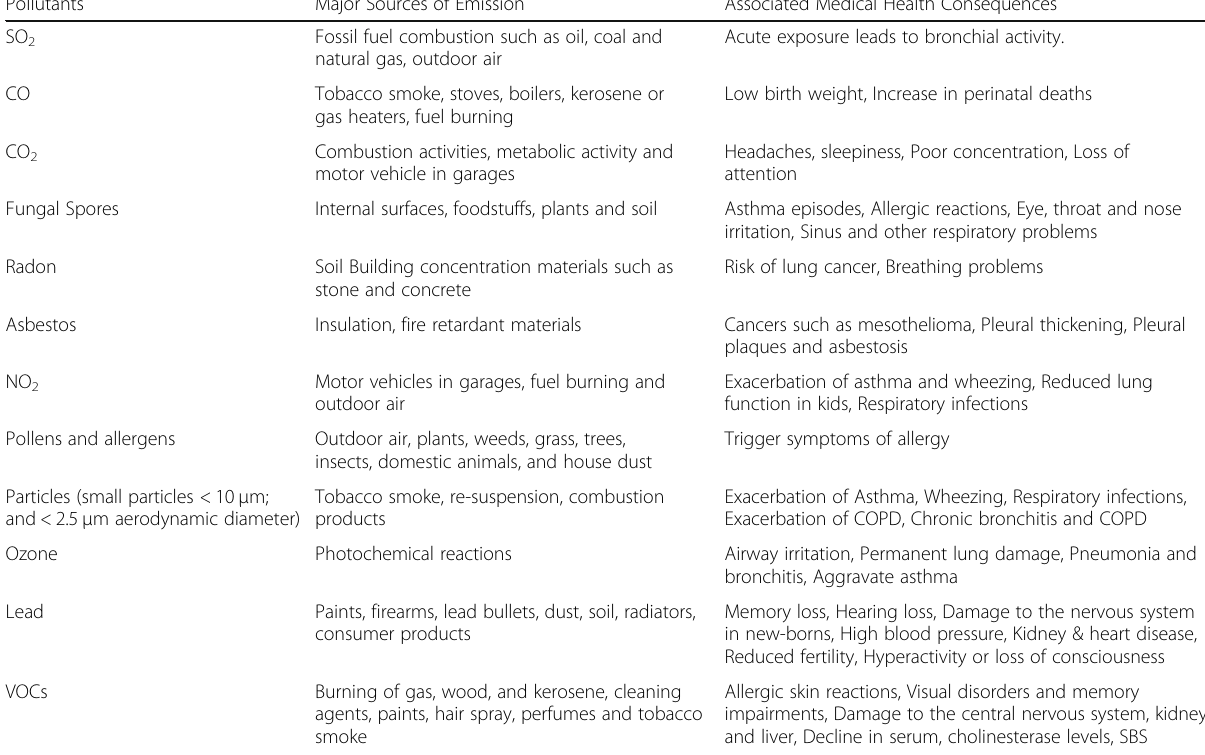
Table 1 Major pollutants affecting the quality of indoor air and the common sources of emission Pollutants Major Sources of